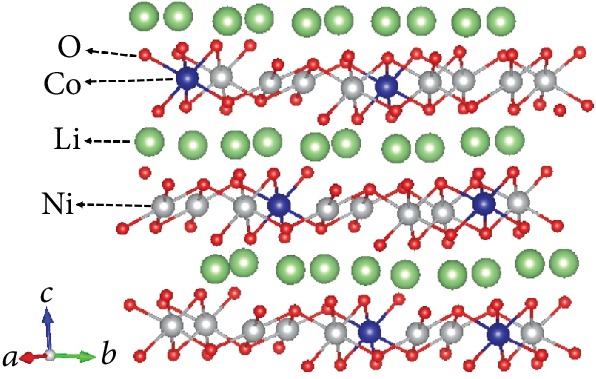
The structure of a 120-atom supercell consisting of 2 × 5 × 1 LiNi0.8Co0.2O2 primitive unit cells.